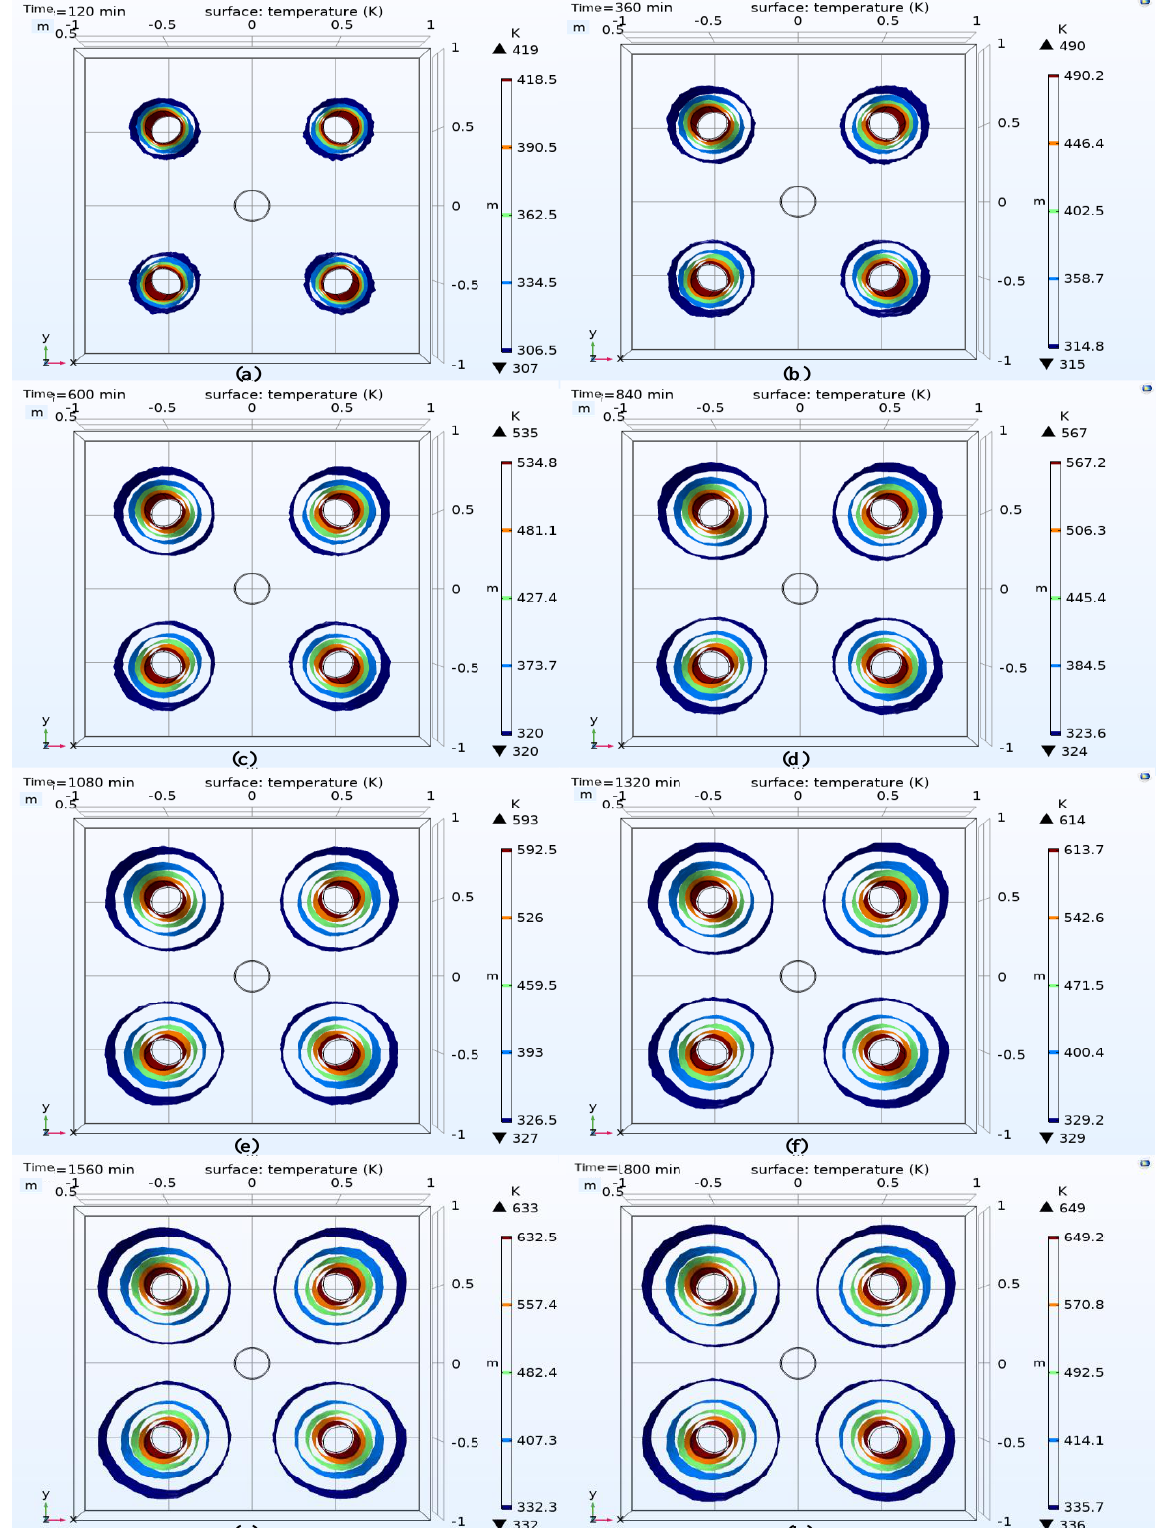
Figure 10. Isosurface of soil temperature distribution in the coupling field. Subgraphs ( a – h ) show the temperature isosurface of porous media every 4 h after the second hour of simulation. The temperatures of different surfaces are given in the legend.